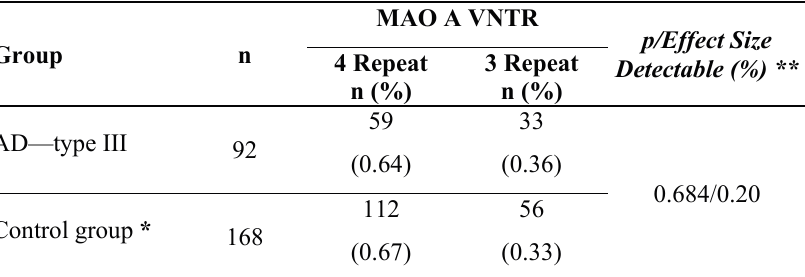
Table 4. Frequency of genotypes of the polymorphism uVNTR of the MAOA gene in patients with alcohol dependence (AD) with Lesch type III and in controls.